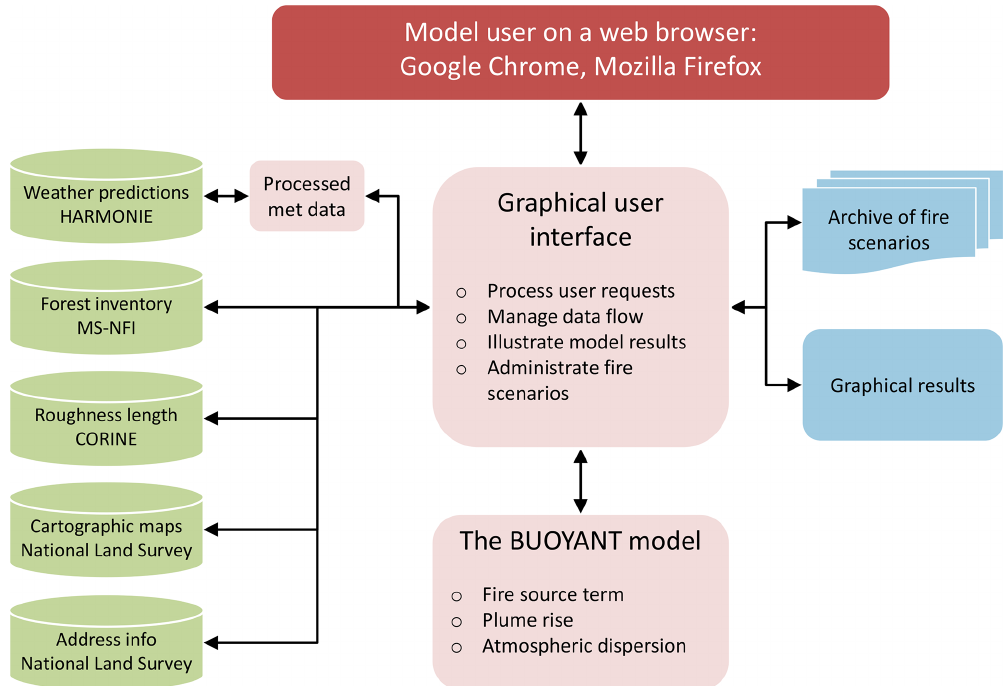
Figure 2. Block diagram of the operational model. Red, green, light red, and blue indicate the internet connections, the data sources, the main modules, and the model output, respectively. The arrows indicate the flow of data. Acronyms: MS-NFI – Finnish Multi-Source National Forest Inventory, CORINE – CoORrdination of INformation on the